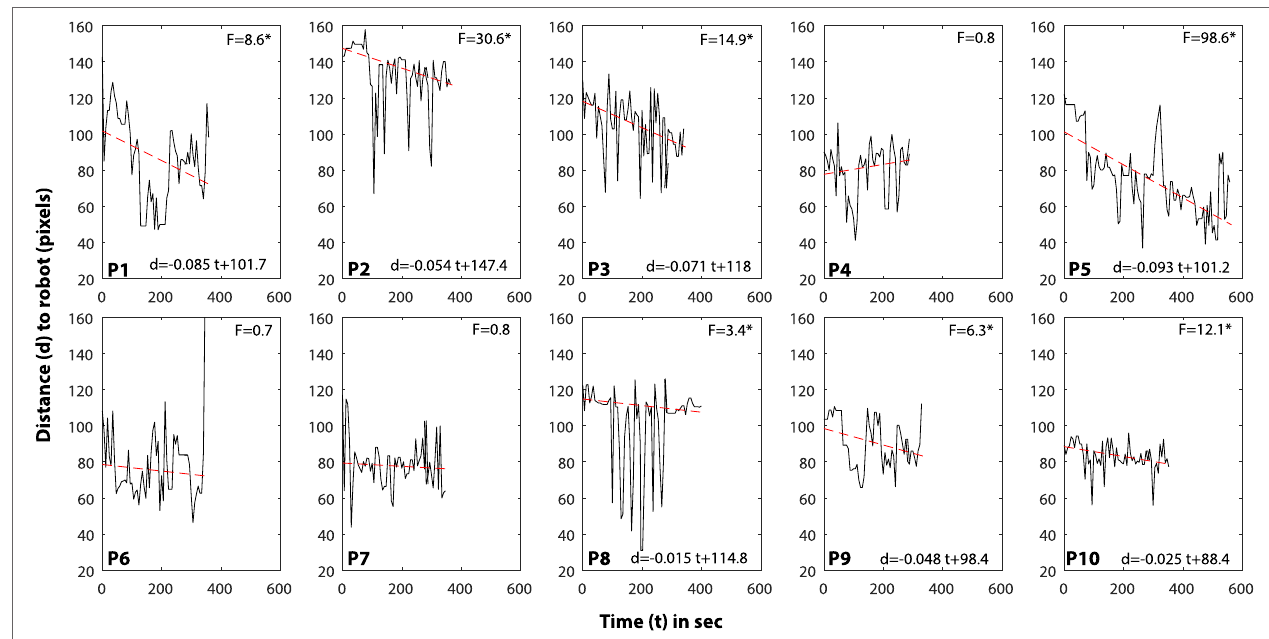
FigUre 10 | Children’s distance from the robot over time. The distance of each participant to the robot is shown in one plot. The Y-axis is distance (in pixels from the facing camera) while the X-axis is the interaction time. The red dashed line indicates the linear trend that is derived from robust linear regression. The ANOVA results to estimate significance of the fit are given in terms of F score for each participant. * indicates significance, and the linear equation is given (at the bottom of the graph) for significant